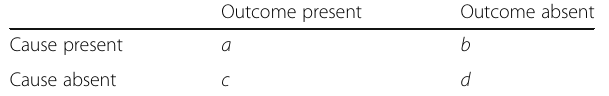
Table 1 Contingency matrix showing the four different trial types as a function of whether the cause and outcome are present or absent Outcome present Outcome absent Cause present a b Cause absent c